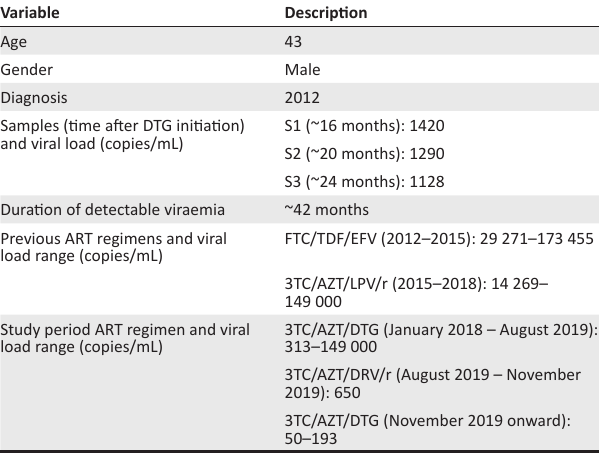
TABLE 1: Patient clinical data and treatment regimens.